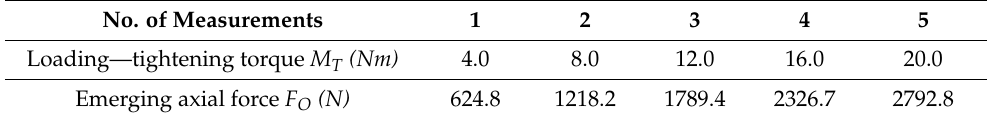
Table 1. Measured values in dry abrasion.